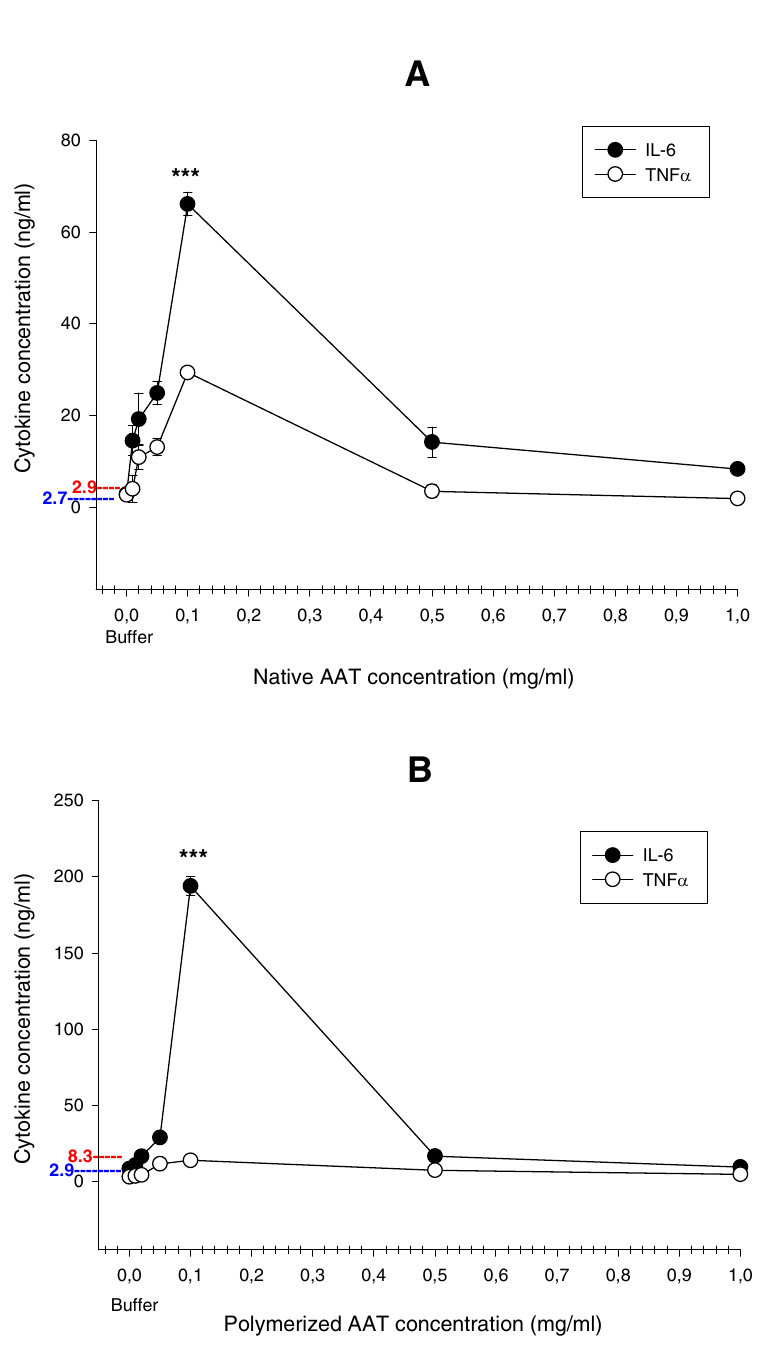
Figure 2 Cytokines released from monocytes stimulated with various concentrations of native (A) or polymerized (B) form of AAT. Each point represents the mean ± SD of six separate experiments. Significantly high up-regulation of the pro-inflammatory cytokines (TNF- α and IL-6) was found when cells were treated with low doses (0.05 and 0.1 mg/ml) of native or polymerized AAT, respectively, compared to control treated with equivalent amounts of buffer alone. The buffer control levels are indi- cated on the graphs (TNF α in blue and IL-6 in